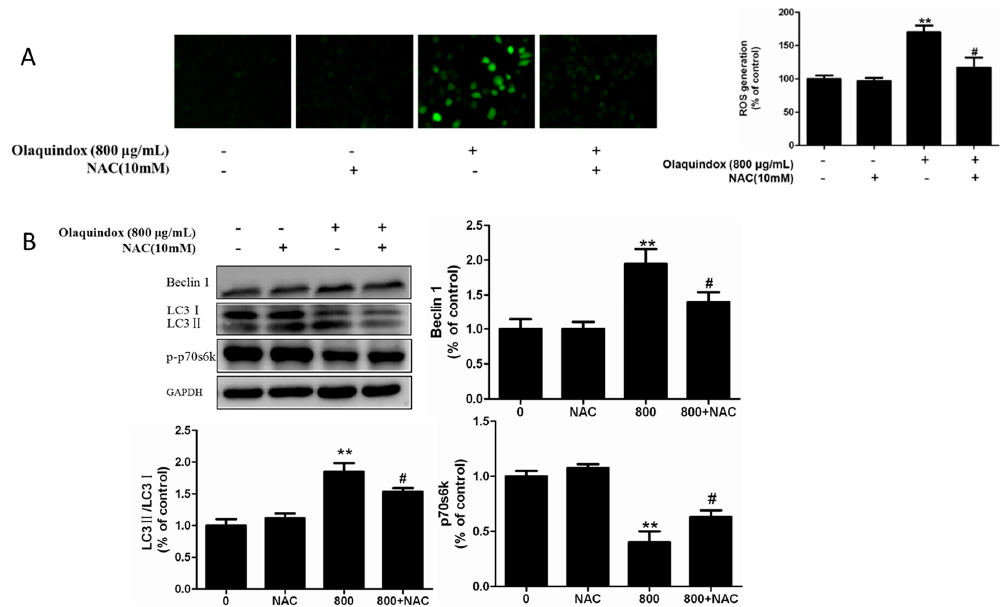
Figure 4. Effect of reduce ROS level on olaquindox induced autophagy. ( A ) NAC alleviated olaquindox-induced generation of ROS. ROS was assessed as described in Figure 2A; ( B ) Cells were pretreated with NAC (10 mM) and the expression of Beclin 1, LC3II/LC3I and p70s6k. All data represents means ± SD from three independent experiments. ** p < 0.01, compared to the control group; # p < 0.05, compared to the olaquindox alone group.